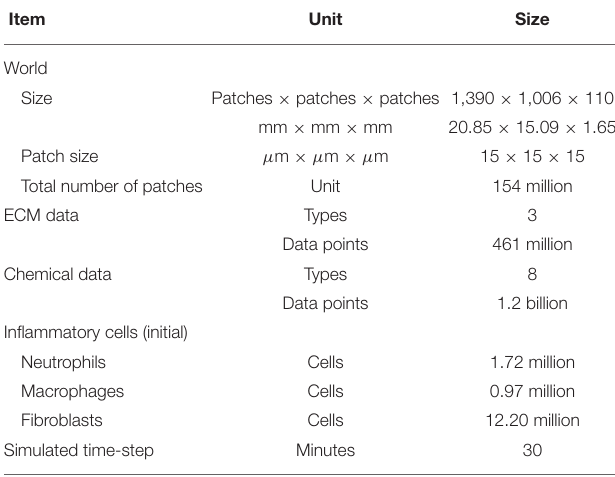
Each Tesla M40 GPU consisted of 3,072 cores per device with TABLE 3 | Summary of human simulation